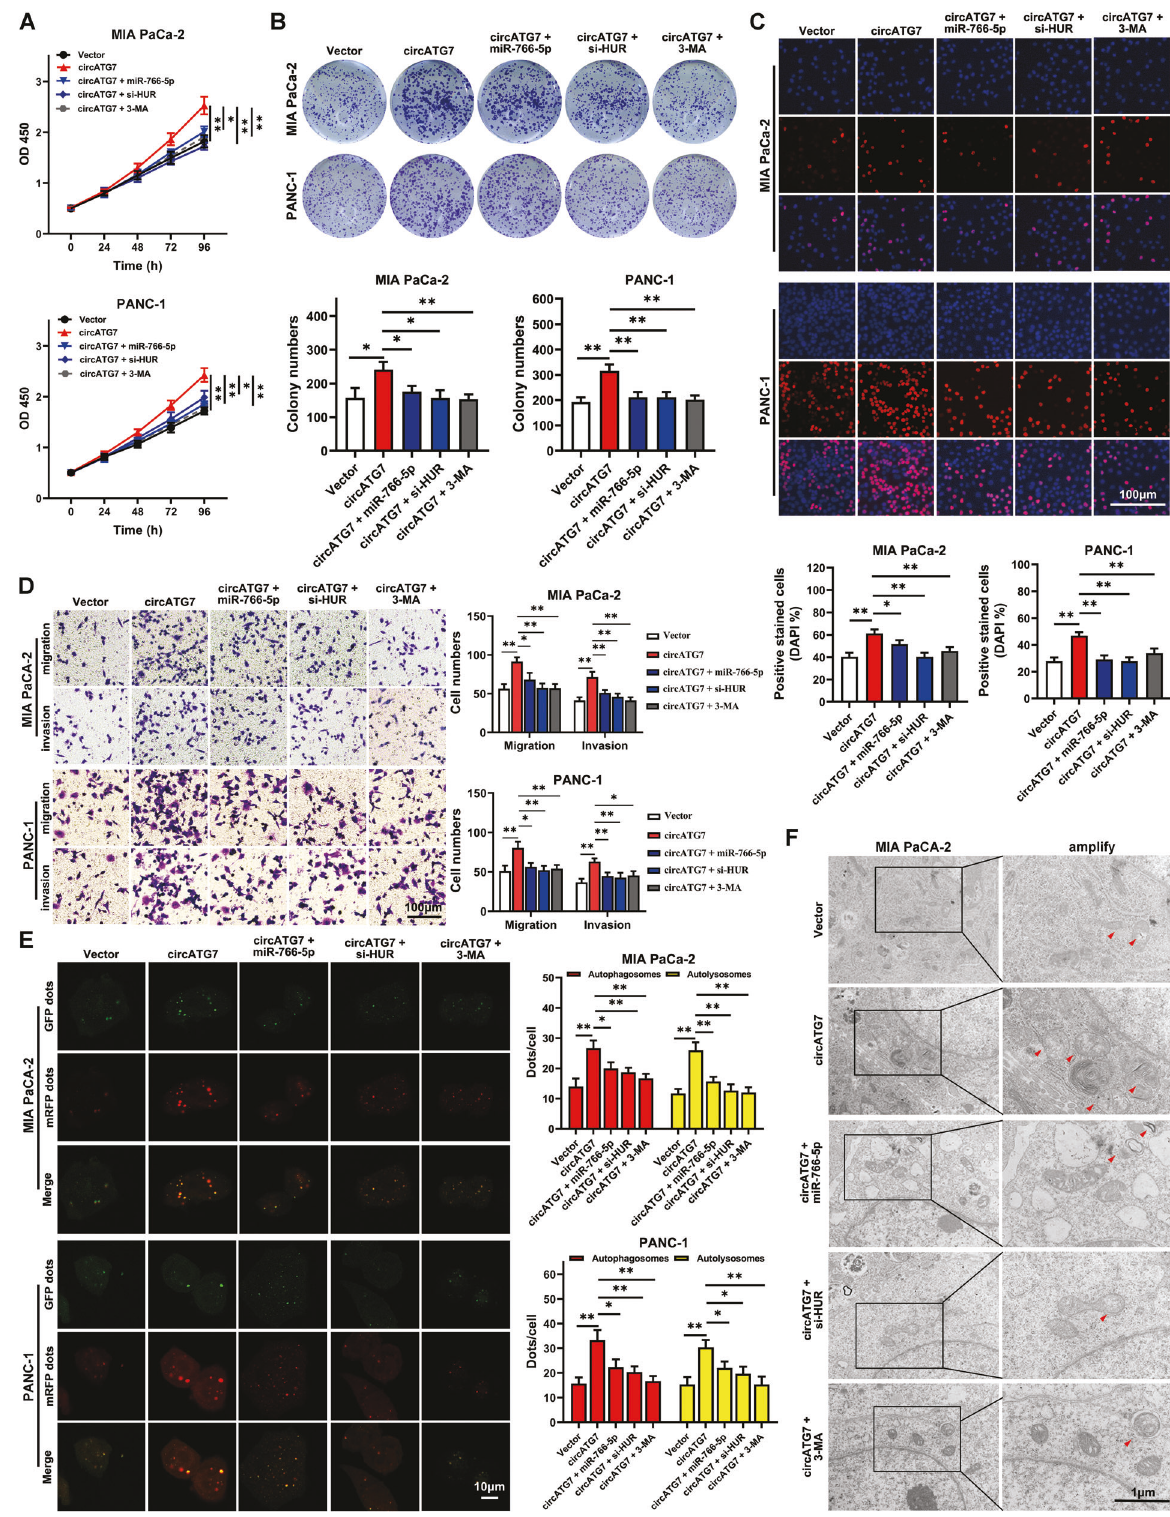
Fig. 7 CircATG7 promoted the proliferation, motility, and autophagy in vitro in a miR-766-5p- and ATG7-dependent manner. PC cells were treated with empty vector, circATG7-overexpressing lentivirus, circATG7-overexpressing lentivirus plus miR-766-5p mimic, circATG7- overexpressing lentivirus plus HUR inhibition and circATG7-overexpressing lentivirus plus 3MA. A CCK-8 assay was used to determine the rate of PC cell proliferation in each group. B EDU assay was performed to detect the rate of EDU positivity in each group. C Colony formation assay was used to detect colony formation in each group. D Migration and invasion Transwell assays were used to determine the rates of migration and invasion in each group. E , F Confocal and transmission electron microscopy were used to detect autophagy in each group of PC cells. Red arrows represent autophagosomes. * P < 0.05; ** P < 0.01.